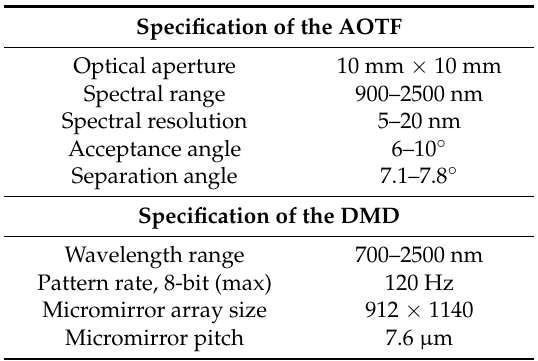
Table 1. Important parameters of the AOTF and DMD.